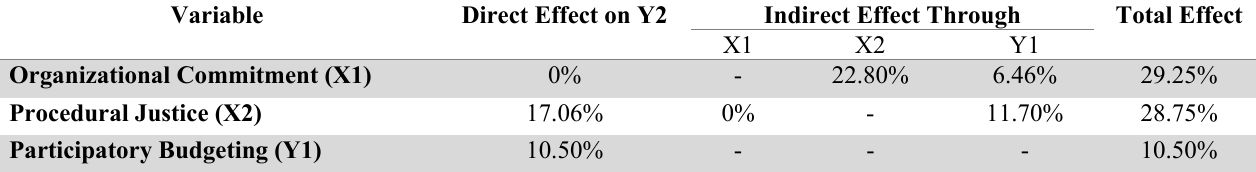
Effect of Exogenous Variables on Endogenous